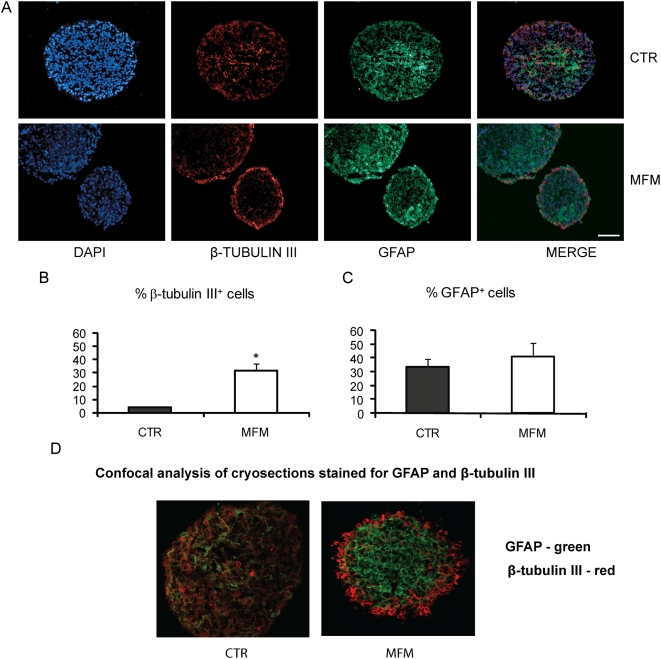
Immunolabeling of hNPC slices for β-tubulin III positive and GFAP positive cells from CTR and MFM groups.GFAP positive cells (green) were found across the whole neurosphere whereas β-tubulin III positive cells (red) were concentrated in the neurosphere core of CTR neurospheres. In the MFM group we can see β-tubulin III positive cells in the borders, without modification in GFAP localization (A). Graphic shows the percentage of β-tubulin III (B) and GFAP (C) positive cells for CTR and MFM groups of hNPC. Note the increase in the percentage of β-tubulin III positive cells in the MFM group compared with CTR (n = 10, t-Student-test, p<0.05). Confocal analysis of cryosections stained for GFAP and β-tubulin III showed that only a very small number of cells within the neurosphere co-label for GFAP and β-tubulin III (D).